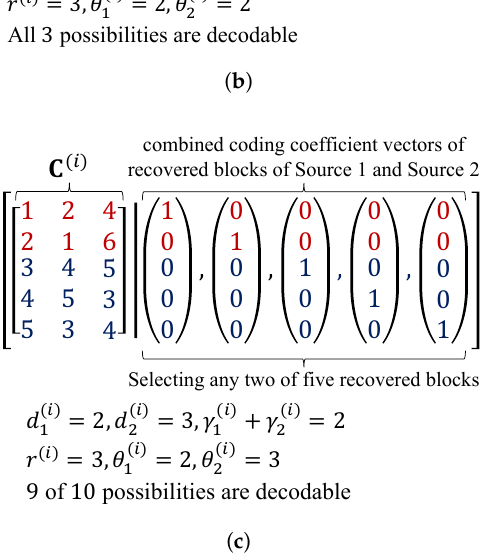
( i ) = 1, γ ( i ) = 2 1 + γ ( i ) = 2, θ ( i ) = 2, θ ( i ) = 3. 2 2 1 1